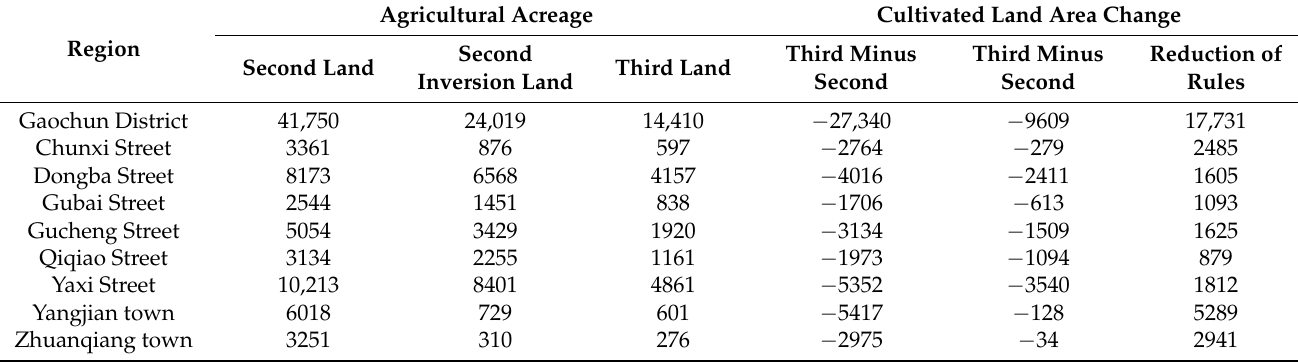
Table 6. Statistical table of cultivated land quantity by street (town) in Gaochun District. Unit: